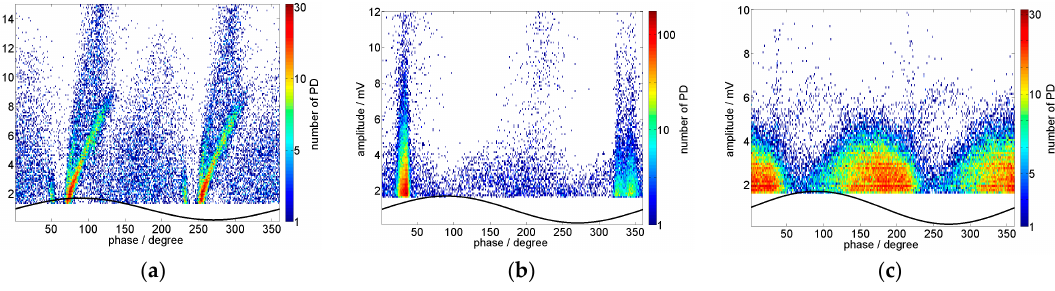
Figure 7 . UHF phase resolved partial discharge patterns (PRPDs): ( a ) Pattern 1; ( b ) Pattern 2; and ( c ) Pattern 3 [14].